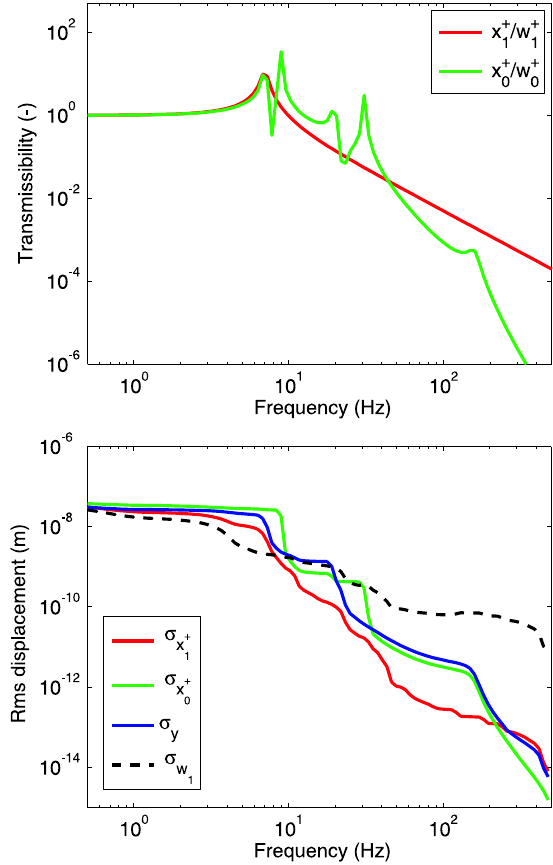
FIG. 13. Transfer functions and integrated rms values of the quadrupoles response for f